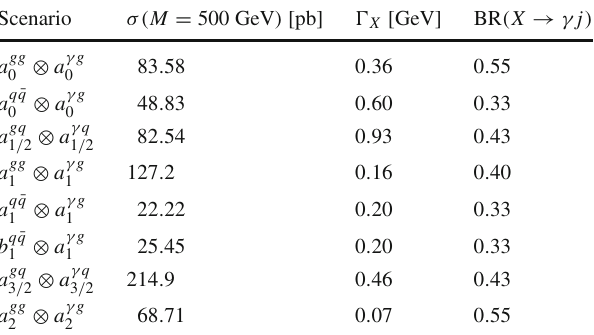
Table 1 Central value cross sections for the γ +jet scenarios discussed in Sect. 3 for coupling values of 10 − 1 . The results for P/CP-violating parameters are identical Scenario